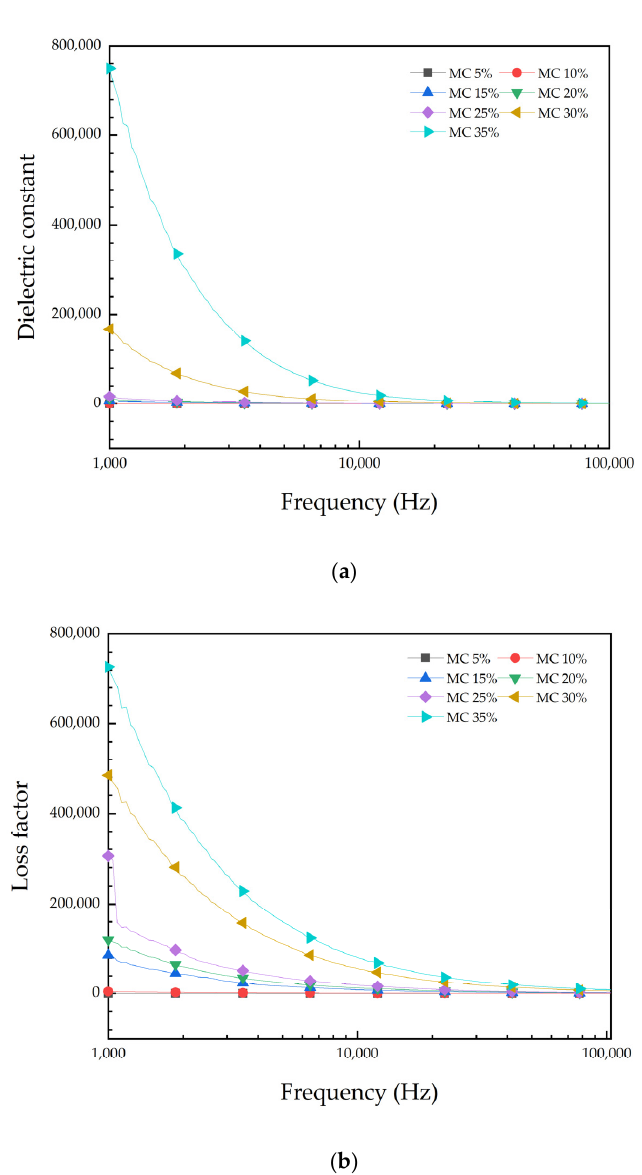
Figure 4. Frequency dependence of dielectric properties at various moisture contents: ( a ) dielectric constant, ( b ) loss factor.